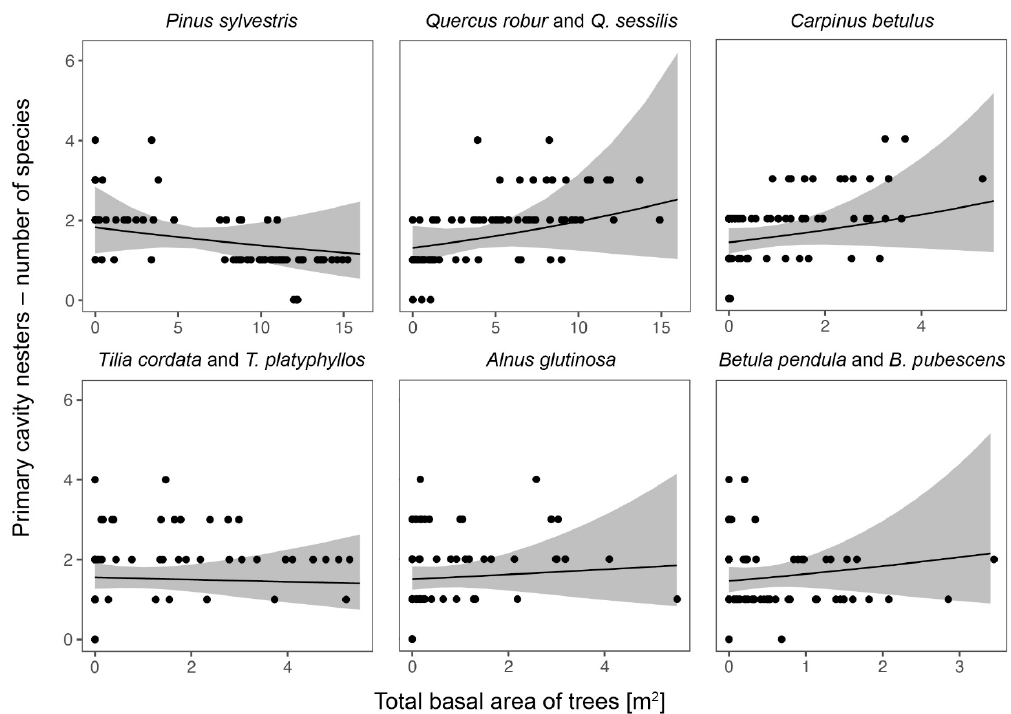
Figure 2. Relationships between species richness of primary cavity nesters (N/10 ha) and total basal area of trees thicker than 20 cm DBH (m 2 /0.45 ha), estimated using generalized linear models (GLMs) with log link function (Table 5). Dots represent measured values, line—prediction, gray area—95% confidence interval for prediction.